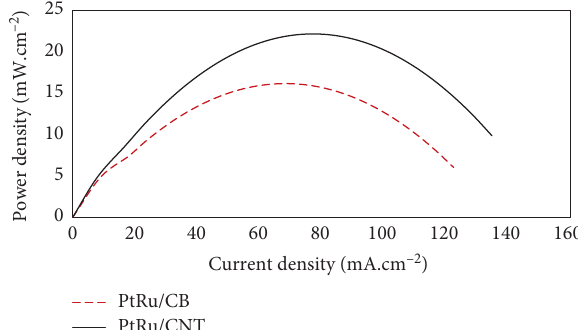
Figure 10: Power curves of the two sets of MEAs under the cell operation. Table 3: Comparison of results of fuel cell maximum output power for different catalysts. Test temperature ( °